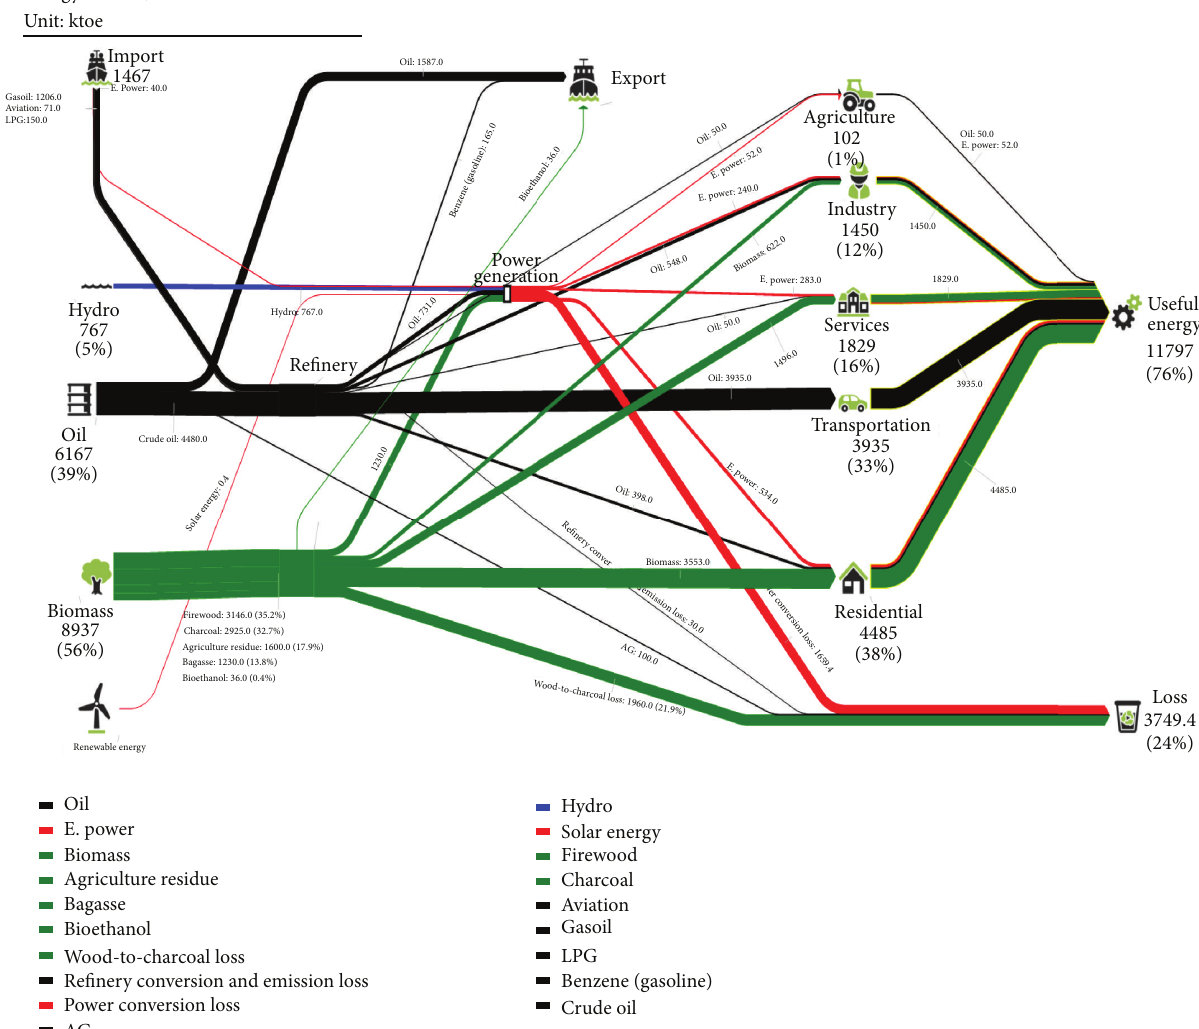
Figure 4: Sankey diagram for Sudan. The data used is energy data for the year 2014. The data does not include private power generation. The renewable energy includes only solar photo voltaic power; the other types of energy, such as wind and geothermal, are not included. The hydro power and biomass energy are made as main categories in energy balance. The power generation efficiency and fuel conversion loss and emissions in the refinery are considered. All units are in ktoe (ton of oil